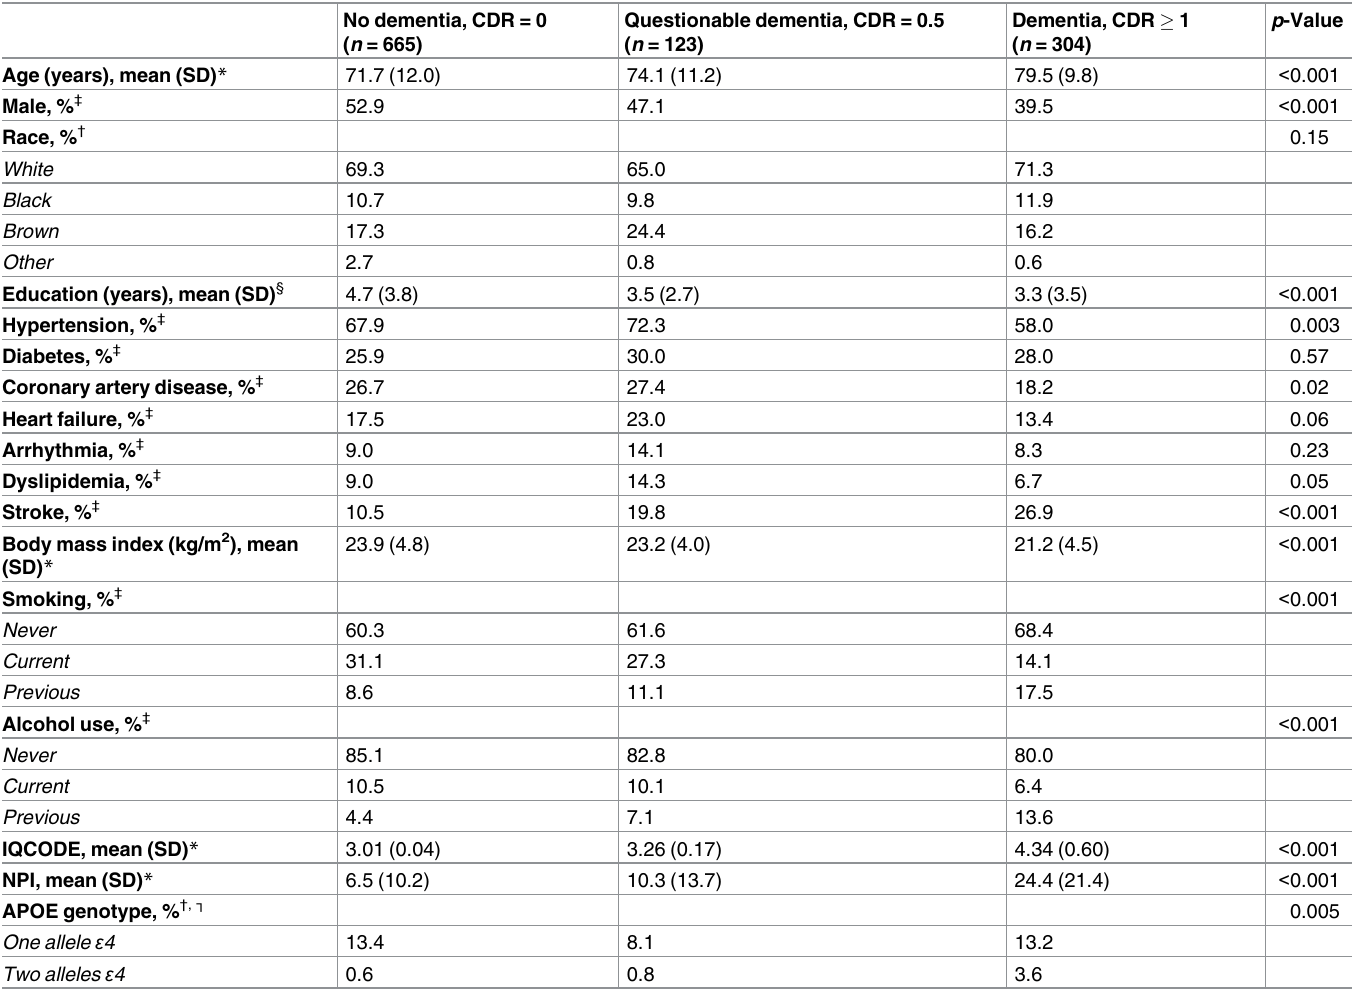
Table 1. Sociodemographics, clinical variables, and APOE genotype, according to dementia status ( n = 1,092). No dementia, CDR = 0 ( n =